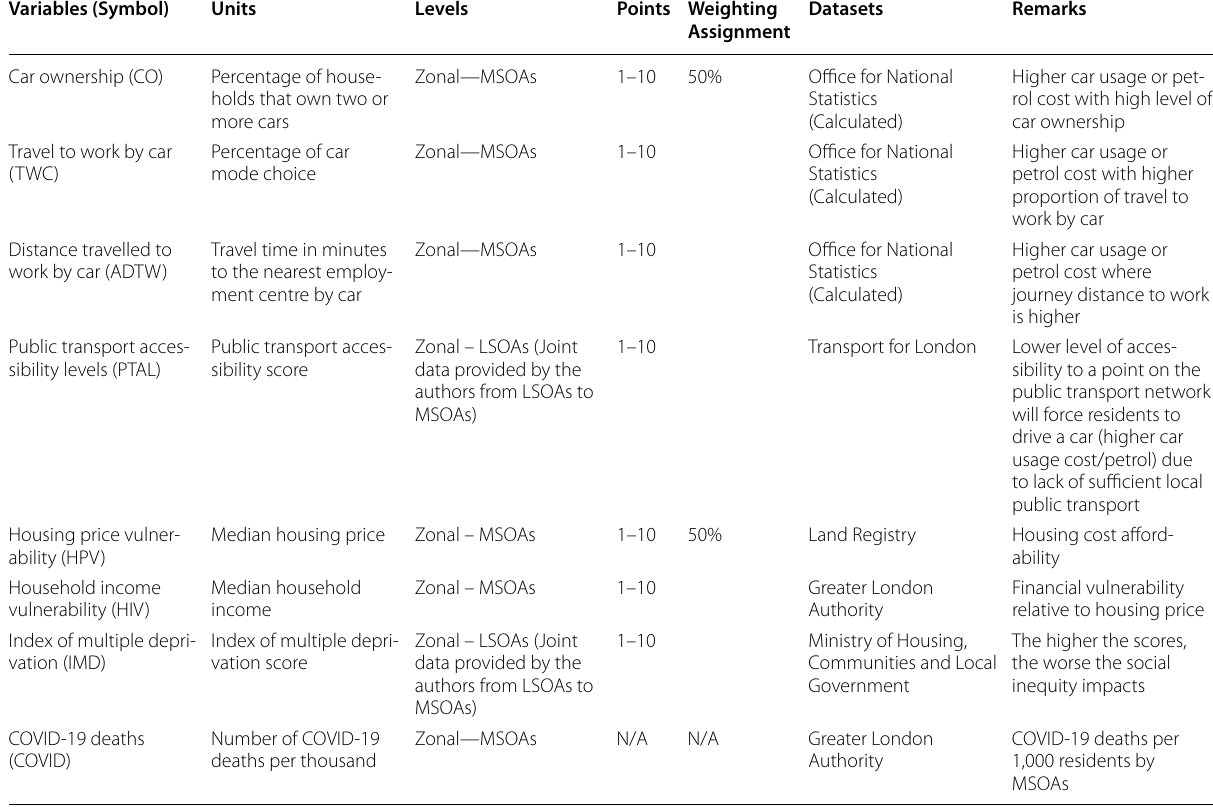
Table 1 Dataset (THASV